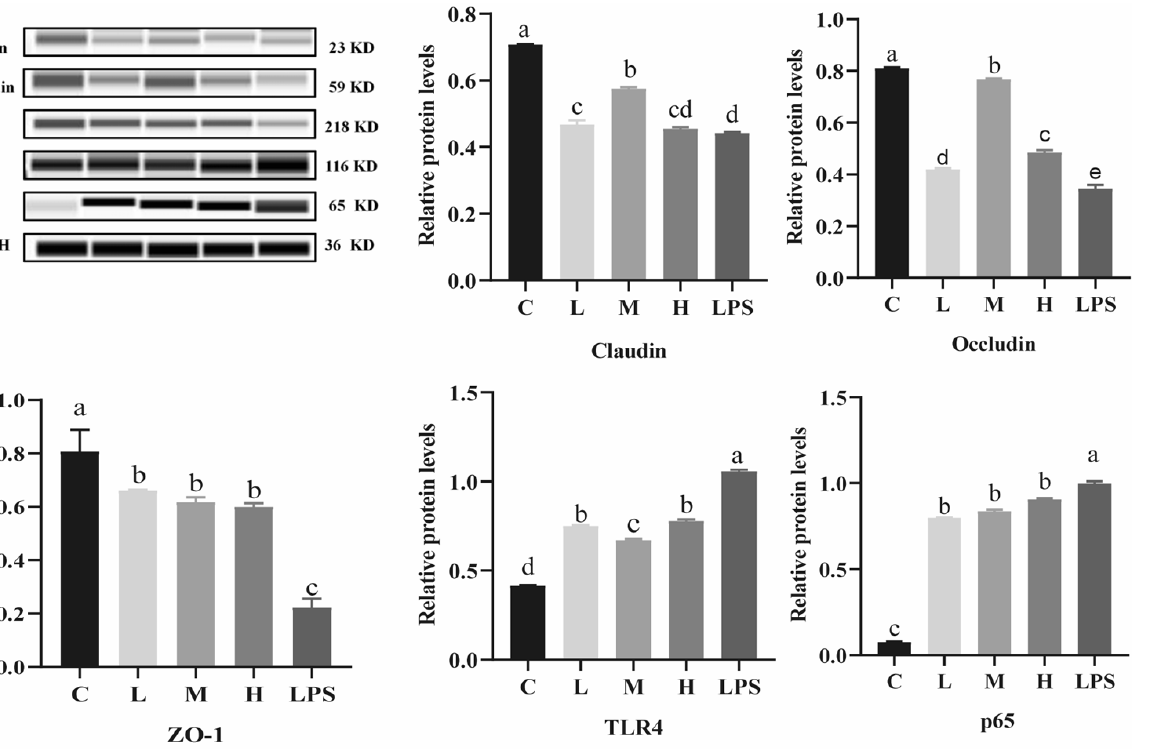
Figure 5. Effects of L. rhamnosus CY12 on tight junction and TLR4/p65 protein expression in LPS-induced Caco-2 Cells. Note: C represents uninduced Caco-2 cells; L, M, and H represent LPS-induced Caco-2 cells co-incubated with 10 7 , 10 8 , and 10 9 cfu/mL L. rhamnosus CY12, respectively; LPS represents LPS-induced Caco-2 cells. Data were presented as mean ± SEM. Means with the different letters are significantly different p < 0.05.